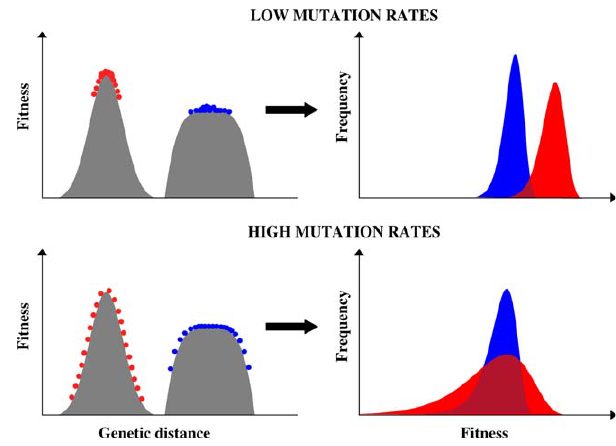
Figure 1. Hypothetical Populations Located at Different Regions of Sequence Space In red, a population with high replication rate but low mutational robustness. In blue, a ‘‘ flat ’’ population with lower replication rate but a higher robustness. Left panel: Dots depict individuals located on each peak at low and high mutation rates. Right panel: Qualitatively expected distribution of individual fitness values for the two populations. Individuals located at the top of the high narrow peak benefit from the highest fitness, although the other population shows lower variance in fitness due to its higher mutational robustness. At low mutation rates, the fitter population will always outcompete the flatter population, but the situation can be reversed at high mutation